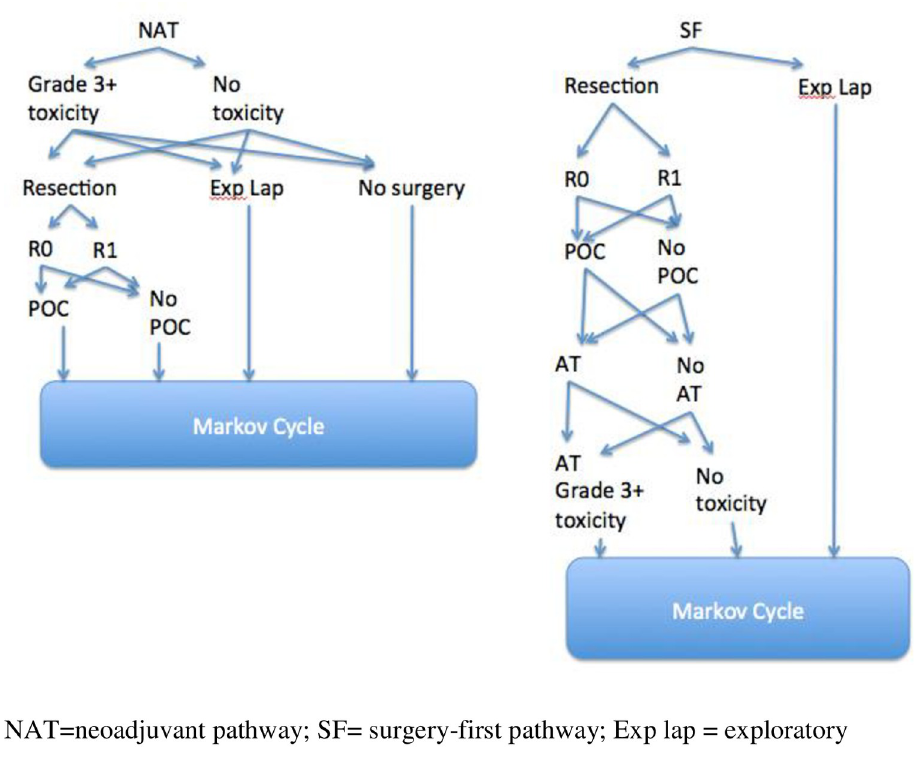
Fig 1. Overview of the structure of the Markov